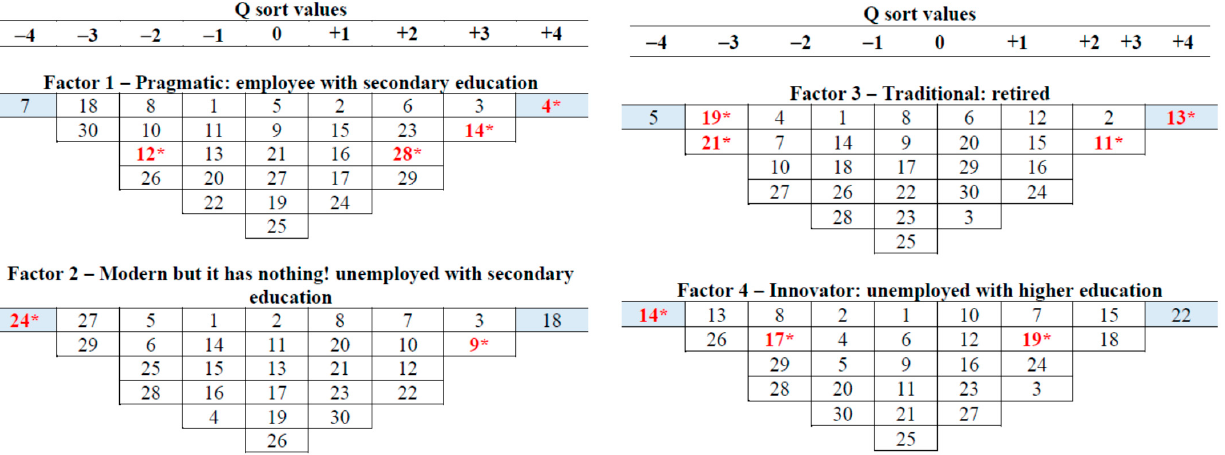
Figure 2. The Q-sort values for each of extracted four factors. (Note: * p -value < 0.01)